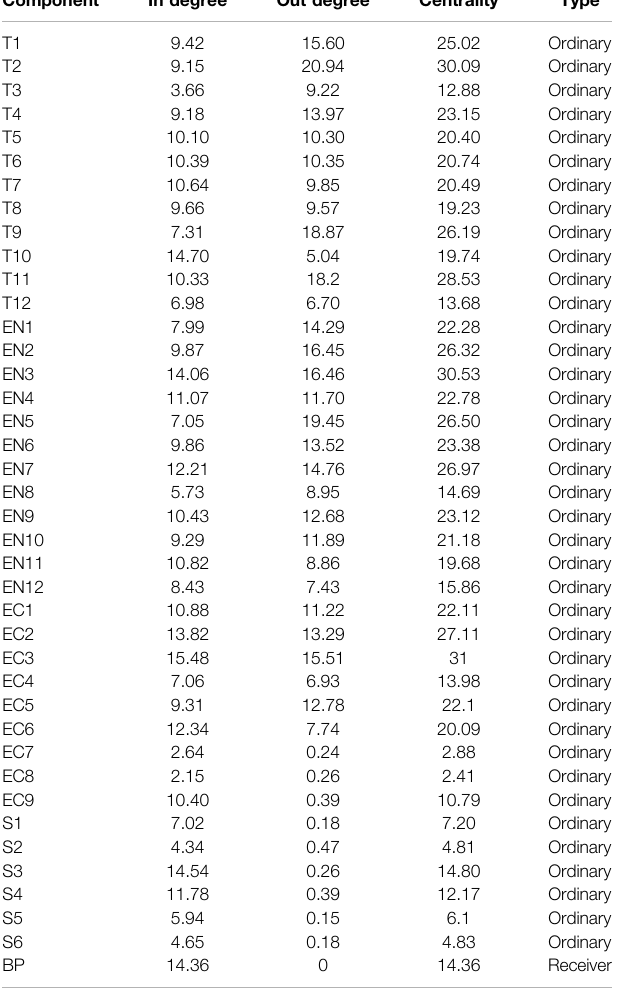
TABLE 11 | FCM statistics and concept metrics. Component In degree